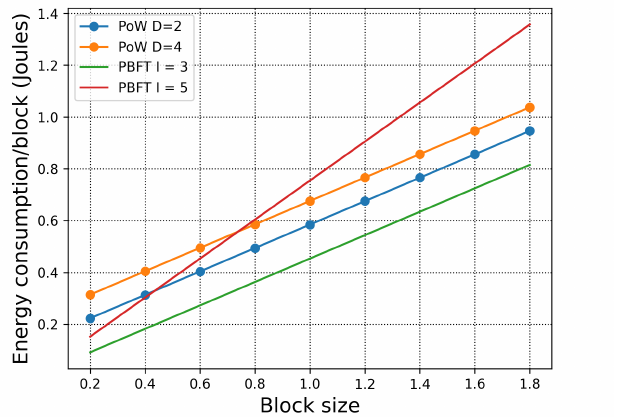
Figure 5. Total energy consumption with respect to the blocksize. With 5 BCAs in 3 organisations for Proof of Work (PoW), and 5 BCAs each organisation for Practical Byzantine Fault Tolerance